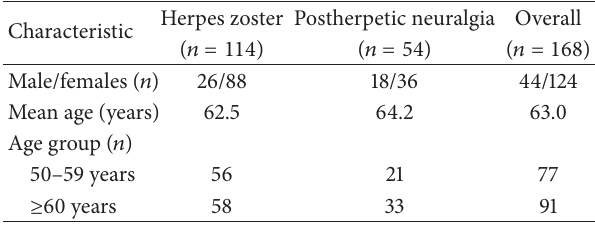
Table 1: Characteristics of the participants in the quantitative telephone